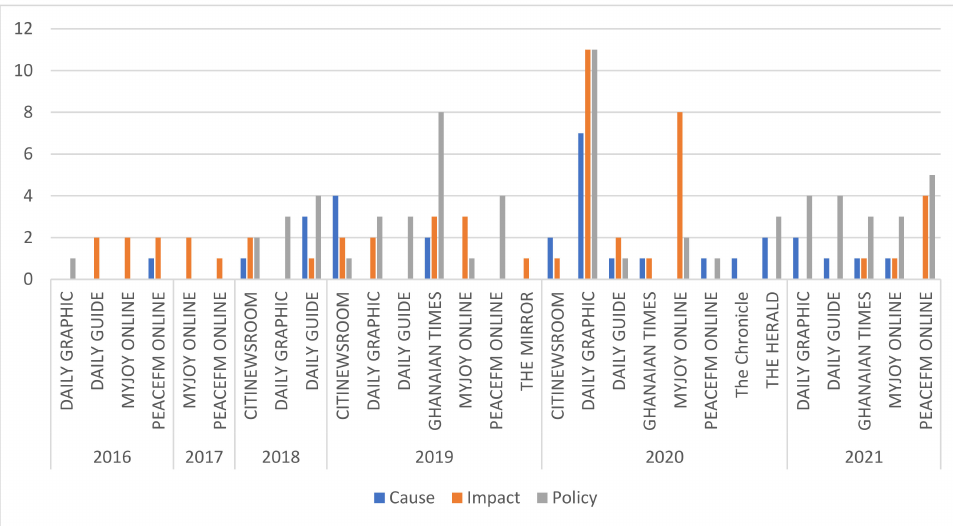
Figure 5. Air pollution publications by Theme per Media House from